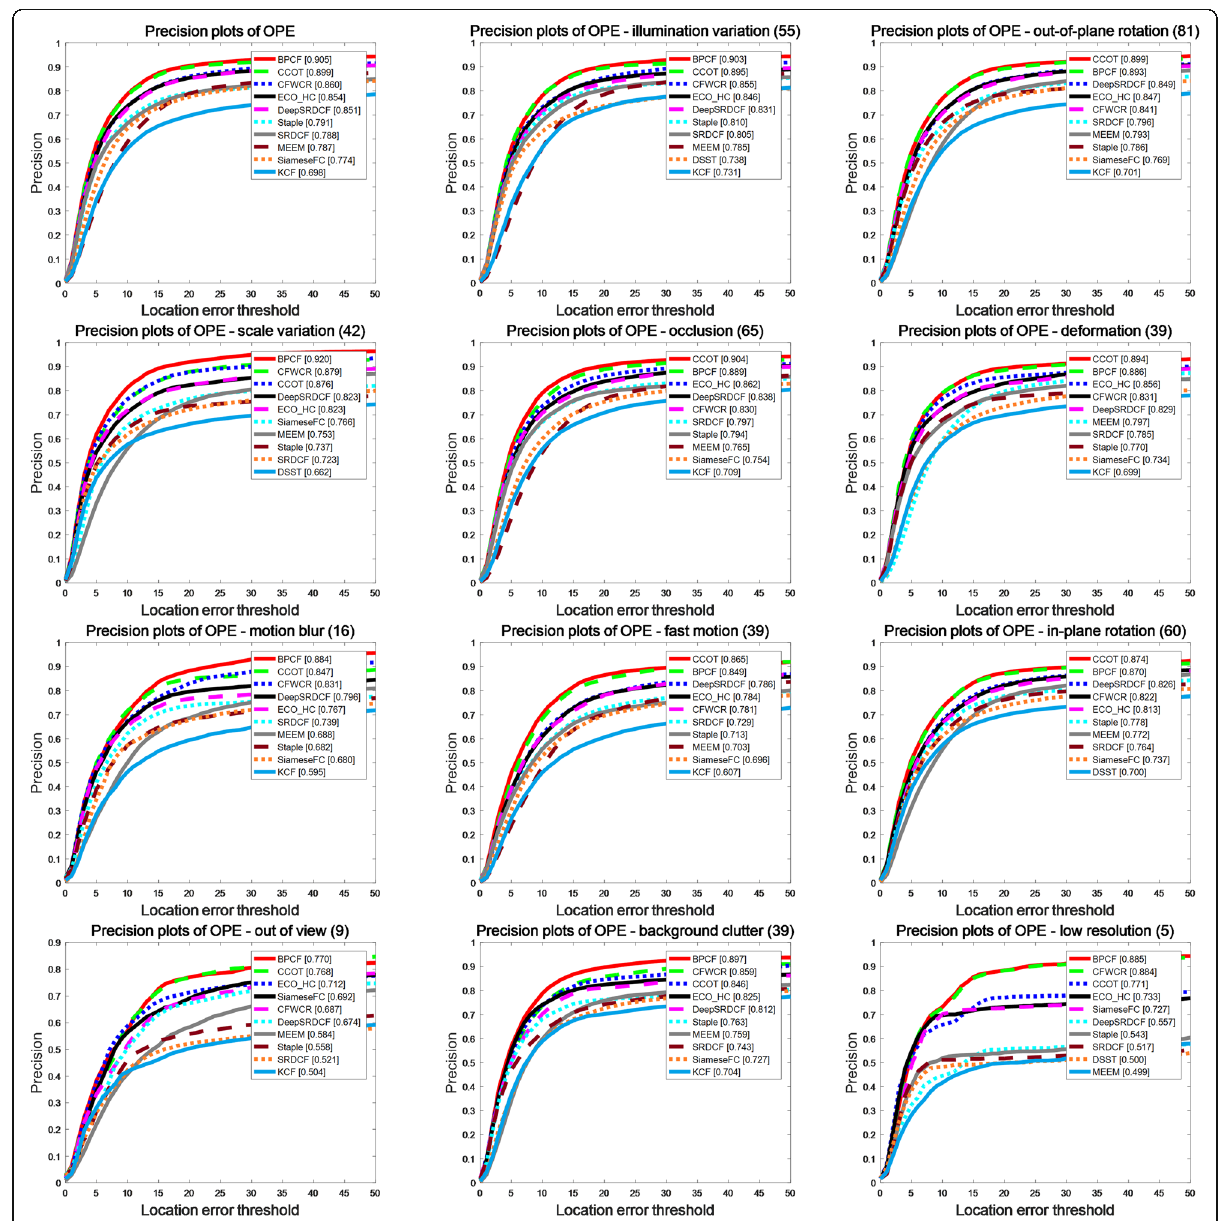
Fig. 6 State-of-the-art comparison. Precision plot of OPE for some of the state-of-the-art trackers and BPCF on OTB-2015